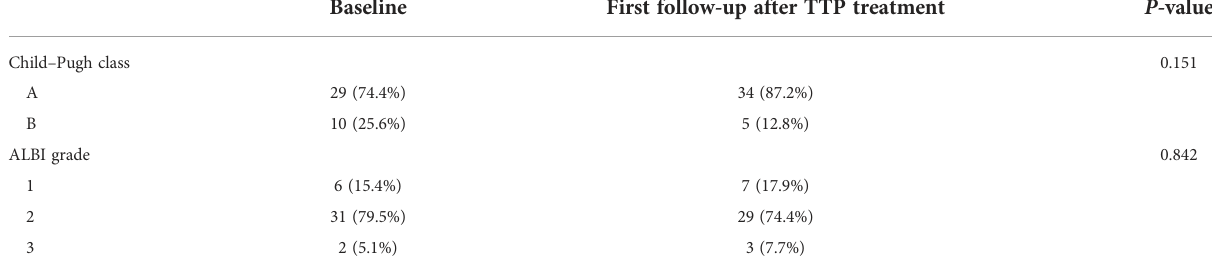
TABLE 5 Change of liver function. Baseline First follow-up after TTP treatment